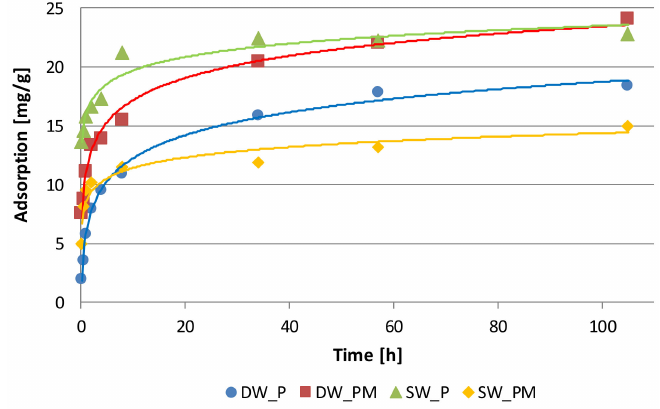
Figure 1. Adsorption kinetics of phosphate ions by alginate matrices cross-linked with Fe 3 + ions. DW_P—deionized water enriched with phosphate, SW_P—e ffl uent from a sludge enriched with phosphate, DW_PM—deionized water enriched with phosphate and metal ions, SW_PM—e ffl uent from a sludge enriched with phosphate and metal ions. Table 1. Estimated pseudo-second-order kinetic model parameters for phosphate adsorption by alginate matrices cross-linked with Fe 3 + ions. DW_P—deionized water enriched with